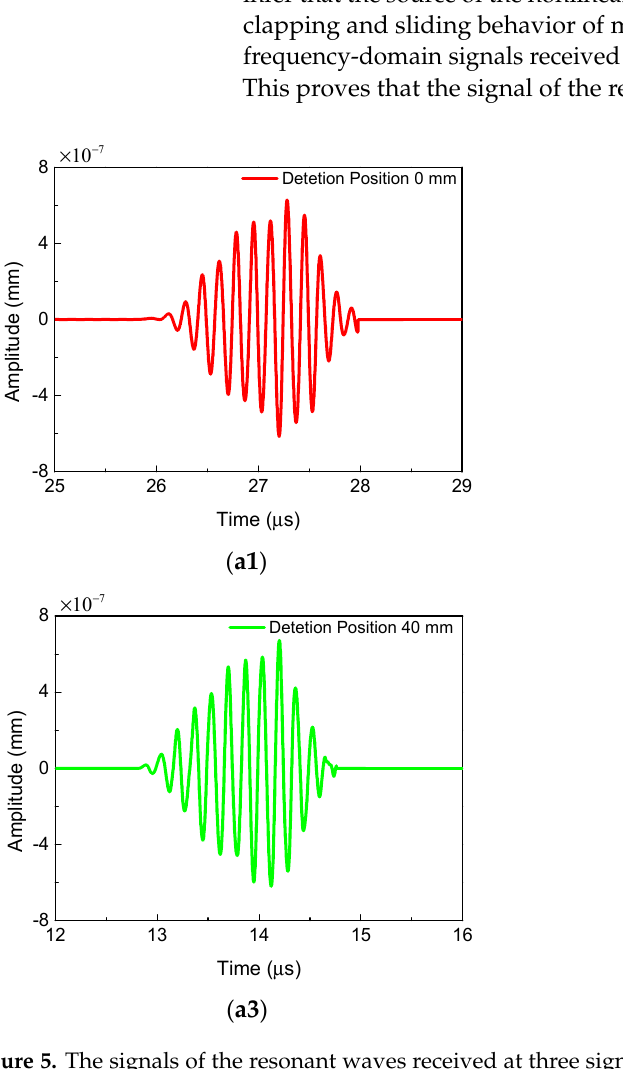
Figure 6. ANP versus crack density ( f R = 6 MHz, μ = 0, L 1 = 40 mm, L 2 = 4 mm, L 3 = 36 mm).